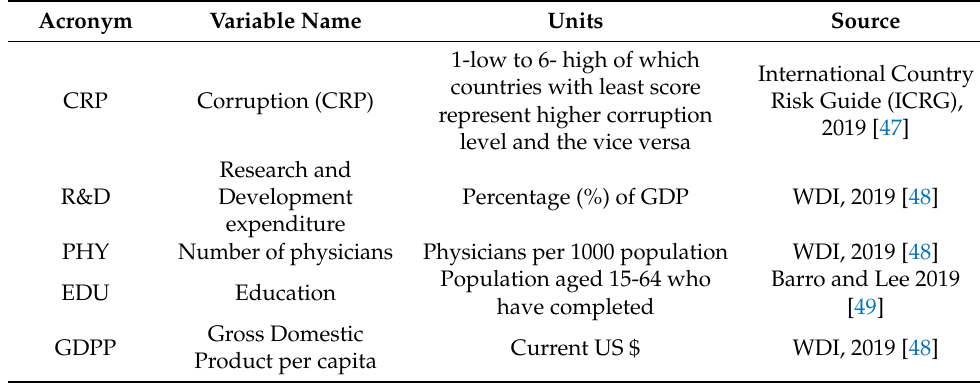
Table 2. Determinants of health